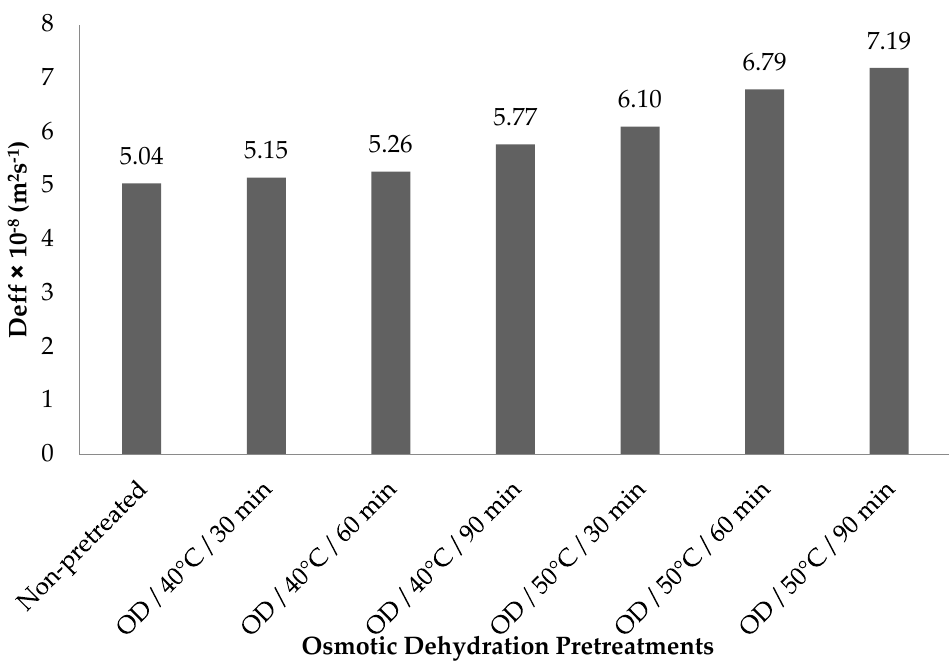
Figure 2. The estimated Deff values of semi-dried kumquat slices.